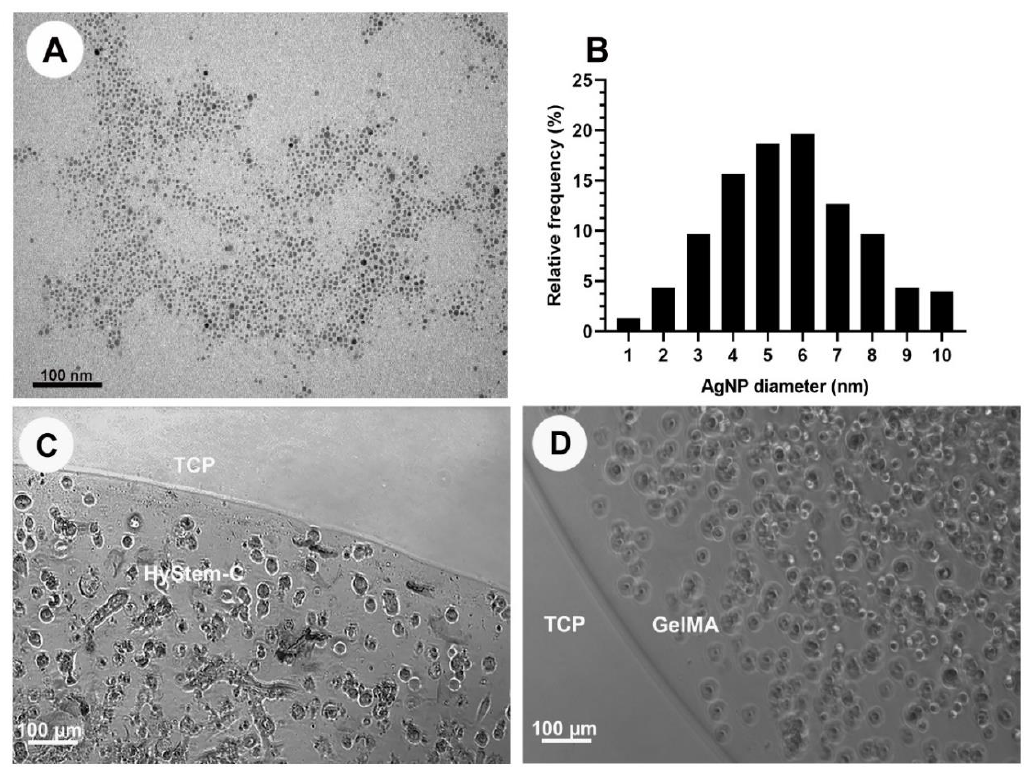
Figure 1. ( A ) Transmission microscope image of alpha-lipoic-acid-capped AgNPs. ( B ) Histogram showing the size distribution of the AgNPs used in the study. ( C ) Human gingival fibroblasts (HGF) encapsulated in stiff HyStem ® -C loaded with 200 µ g/mL AgNPs at 48 h. ( D ) HGF encapsulated in standard GelMA loaded with 200 µ g/mL AgNPs at 48 h. TCP—tissue culture plastic.